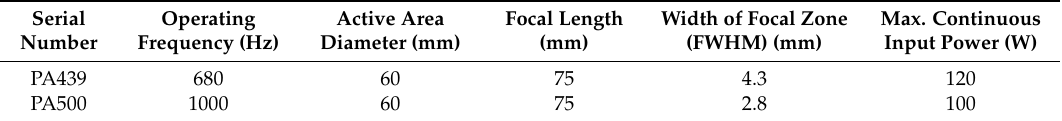
Table 1. HIFU transducer